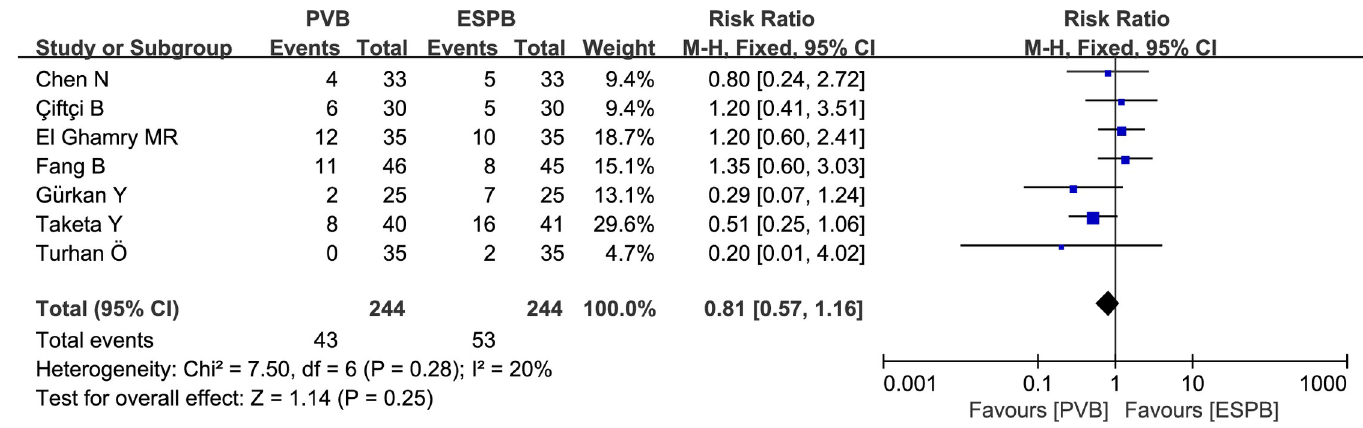
Fig 9. Forest plot of